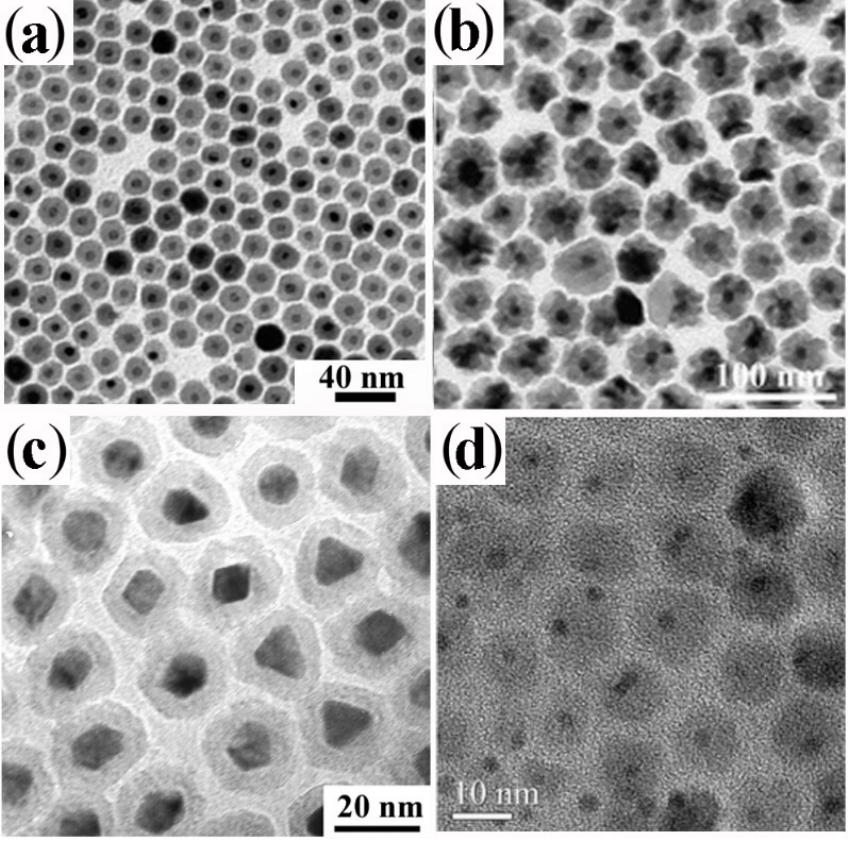
Figure 2. Gallery of representative core@shell CNHSs, prepared by direct heterogeneous nucleation and growth of a shell of a different material (cf. Scheme 2a). The panels display low-magnification TEM overviews and HRTEM images of: ( a , b ) spherical and flower-like Au@Fe 3 O 4 CNHSs (repro- duced with permission from Ref. [99], Copyright 2006, American Chemical Society); ( c ) spherical Pt@Fe 2 O 3 CNHSs (reproduced from with permission Ref. [105], Copyright 2005, IOP Publishing; ( d ) nearly spherical FePt@ZnO CNHSs (reproduced with permission from Ref. [95], Copyright 2010, Wiley-VCH Verlag GmbH & Co. KGaA).